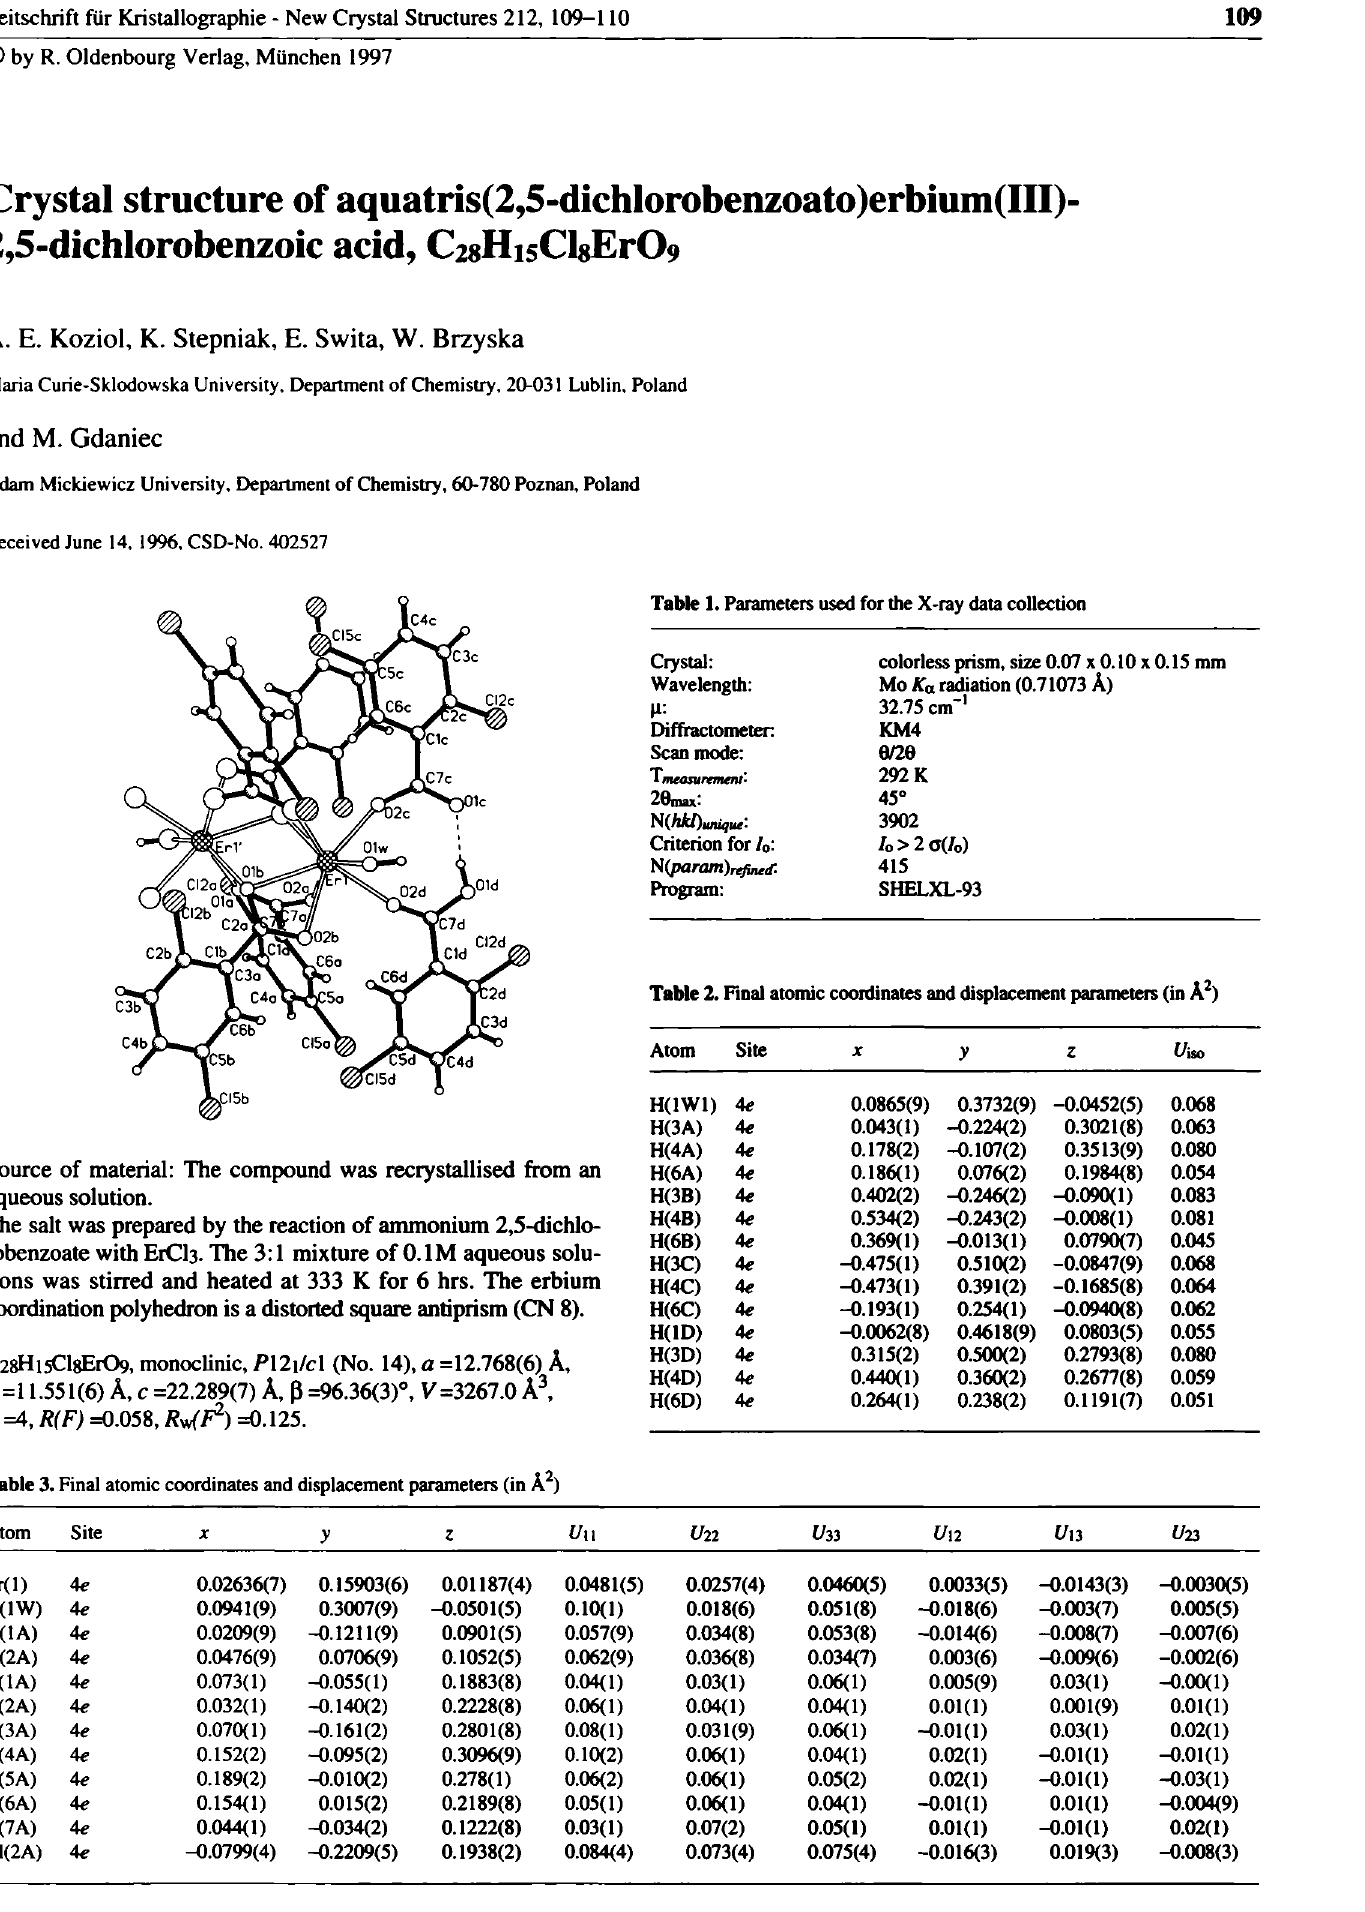
Table 3. Final atomic coordinates and displacement parameters (in Â 2 ) Atom